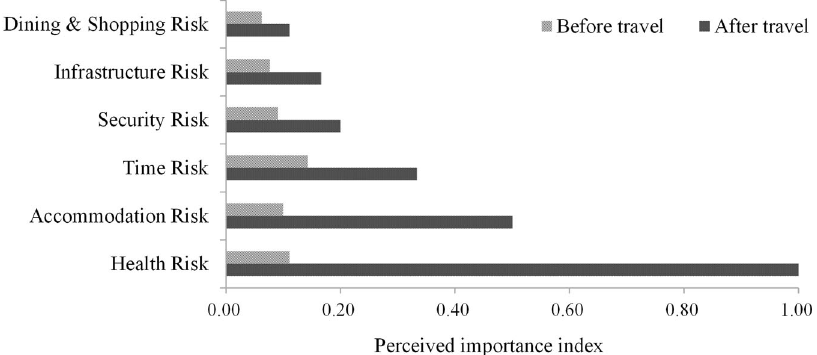
Fig. 8 Risks with perceived importance signi fi cantly increased after travel. The experiment results indicate that these risks are grossly underestimated by tourists before travel.